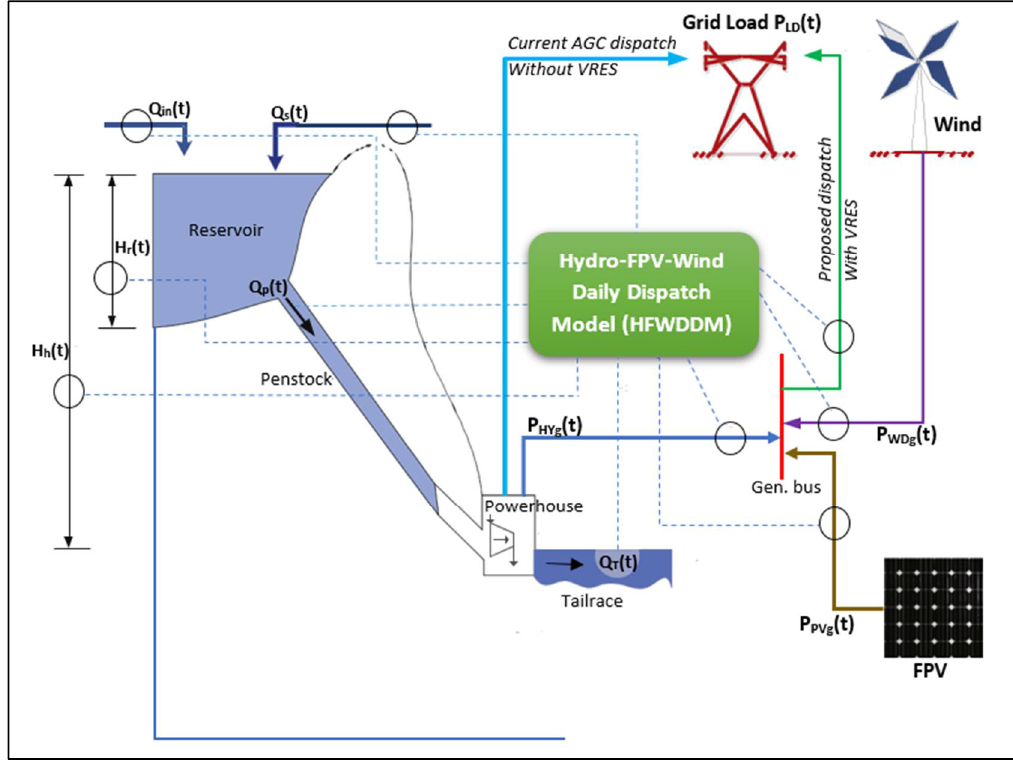
Figure 5. Diagram showing the schematic for the hydro-FPV-wind grid-tied system (adopted from [107]). Reproduced from [107], the name of the publisher: Elsevier 2019.